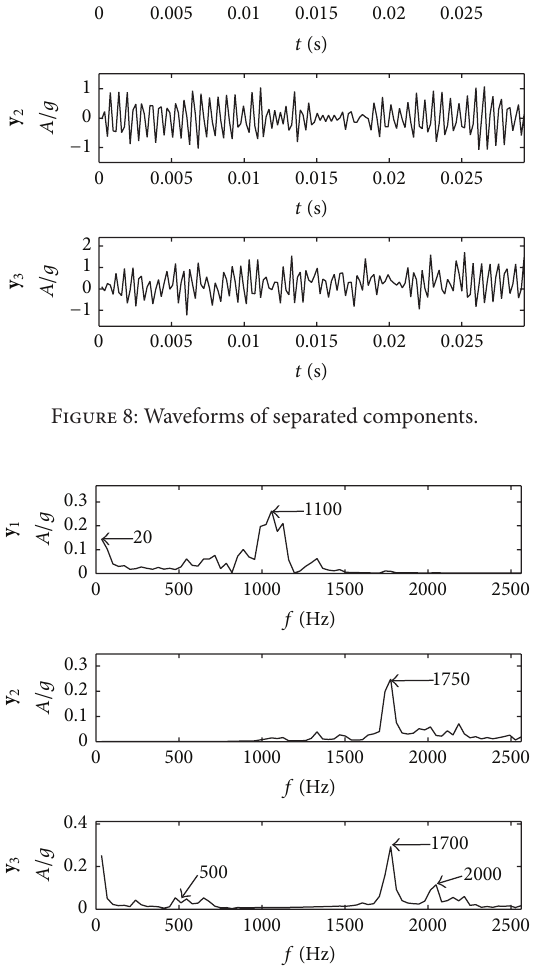
Figure 7: Spectrums of the mixed signals.